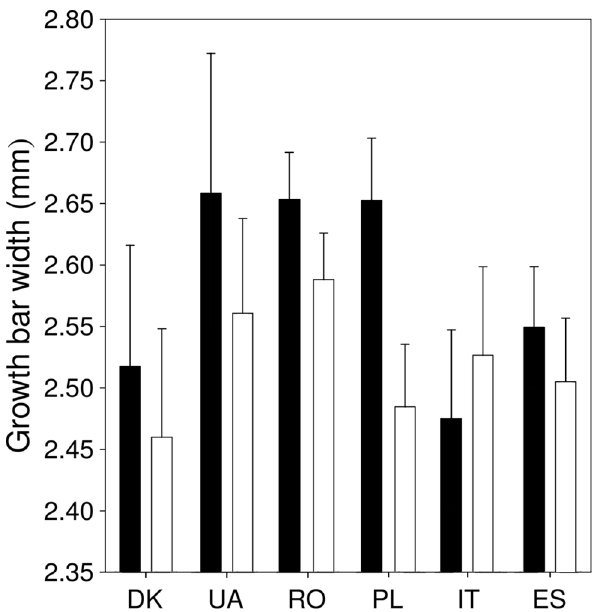
Fig 5. Variation in GBW of Ta6 in male (black) and female (white) barn swallows from six European populations (DK — Denmark, UA — Ukraine, RO — Romania, PL — Poland, IT — Italy, ES — Spain) (mean +